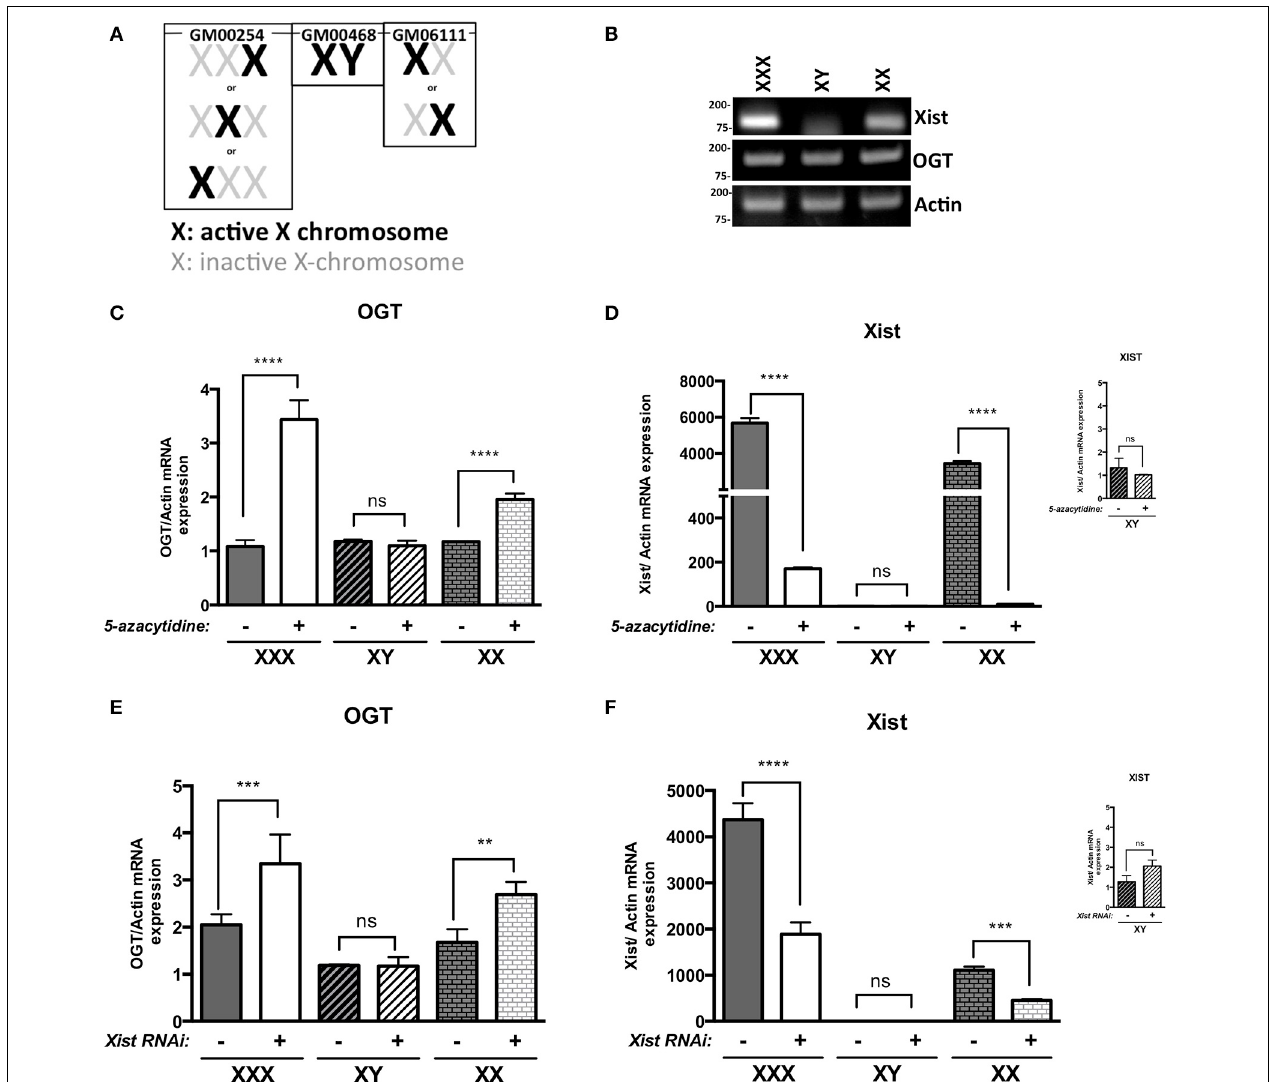
FIGURE 1 | OGT is subject to X-inactivation in females. (A) Male (GM00468), Female (GM6111) and triple-X (GM00254) human fibroblasts show different X-inactivation profiles: no Xi in male, one Xi in female and 2 Xi in triple-X female cells. (B) XIST mRNA expression, analyzed by RT-PCR, is increased with Xi status. OGT expression remains the same in the different cell lines. (C) 5-azacytidine, a DNA methylation inhibitor, increases OGT mRNA expression according to the number of Xi, analyzed by qRT-PCR and